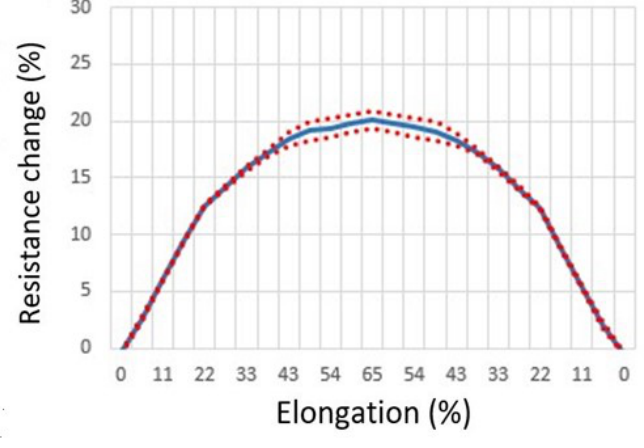
Figure 7. Measured resistance variation at different strain points after a washing cycle. Up and down strain cycle and repeatability (dot line) are represented.